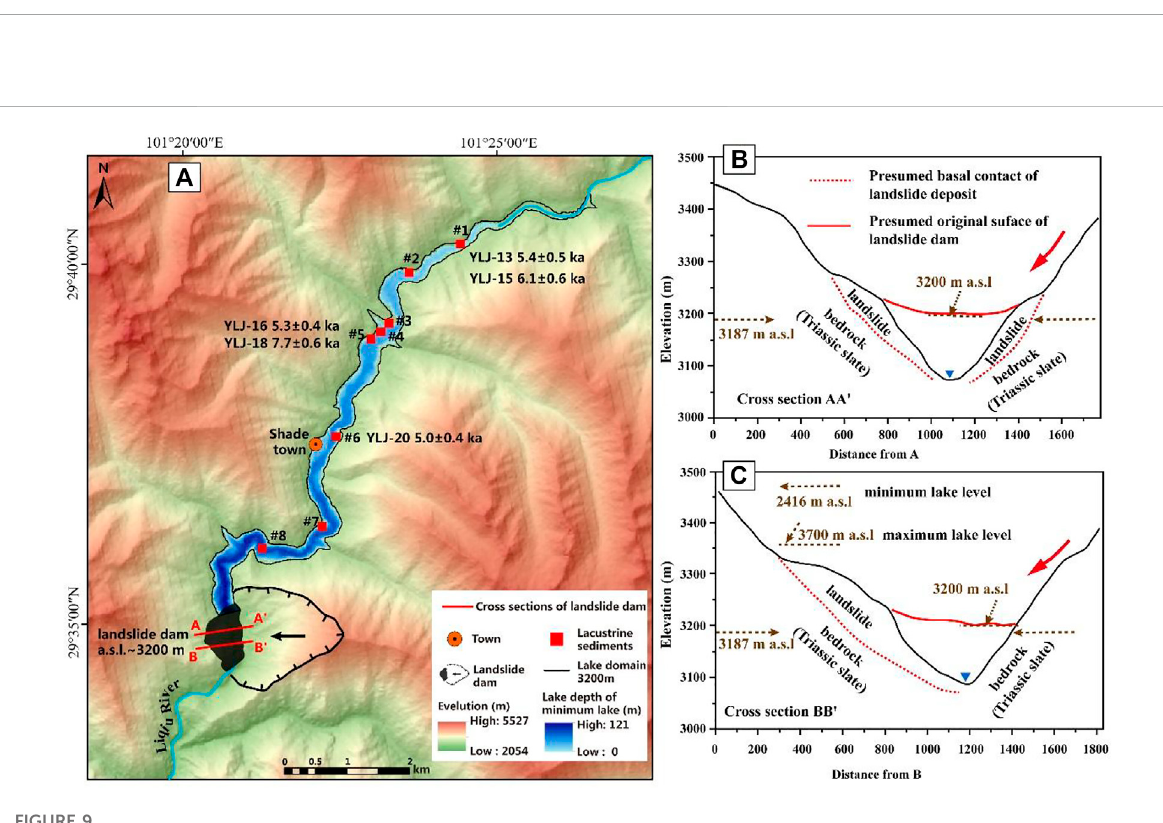
FIGURE 8 Equivalent dose distribution of samples in the Abanico plot (Dietze et al., 2016), which is a combination of radial, histogram, and probability density plots. (A – D) represent the Abanico plot of YLJ-11, YLJ-13, YLJ-16 and YLJ-15.